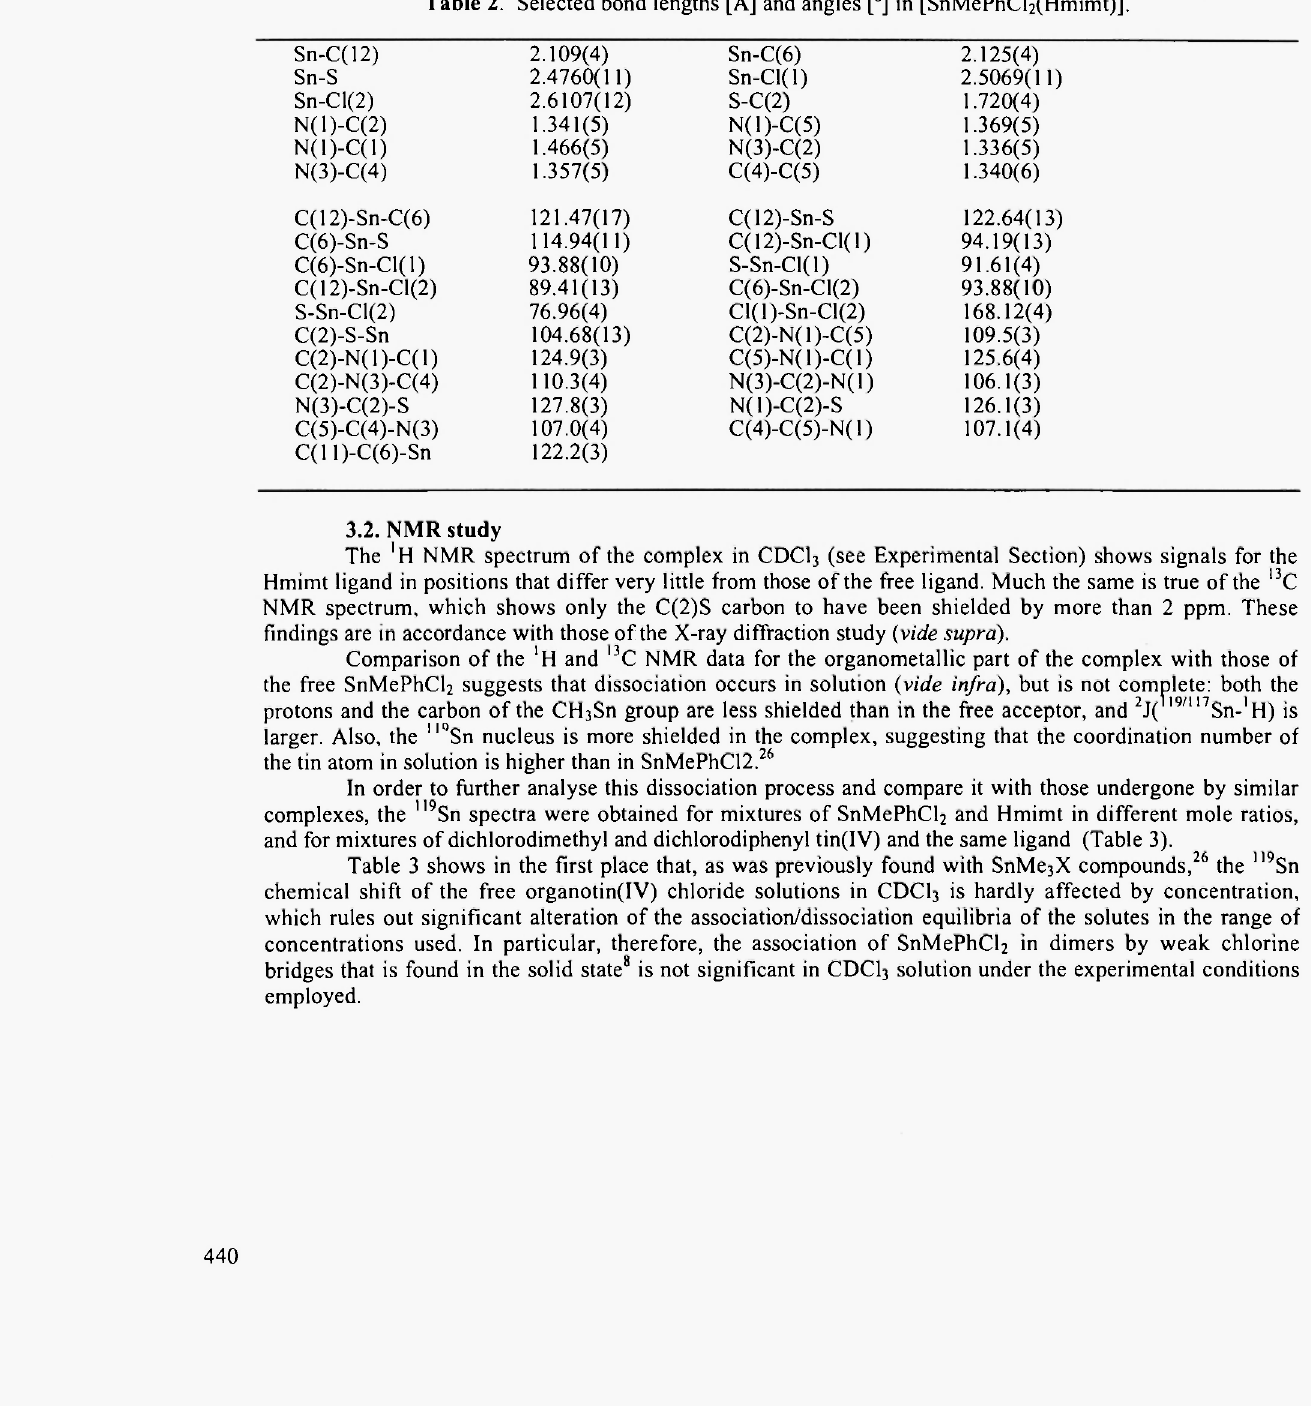
Table 2. Selected bond lengths [A] and angles [°] in [SnMePhCl 2